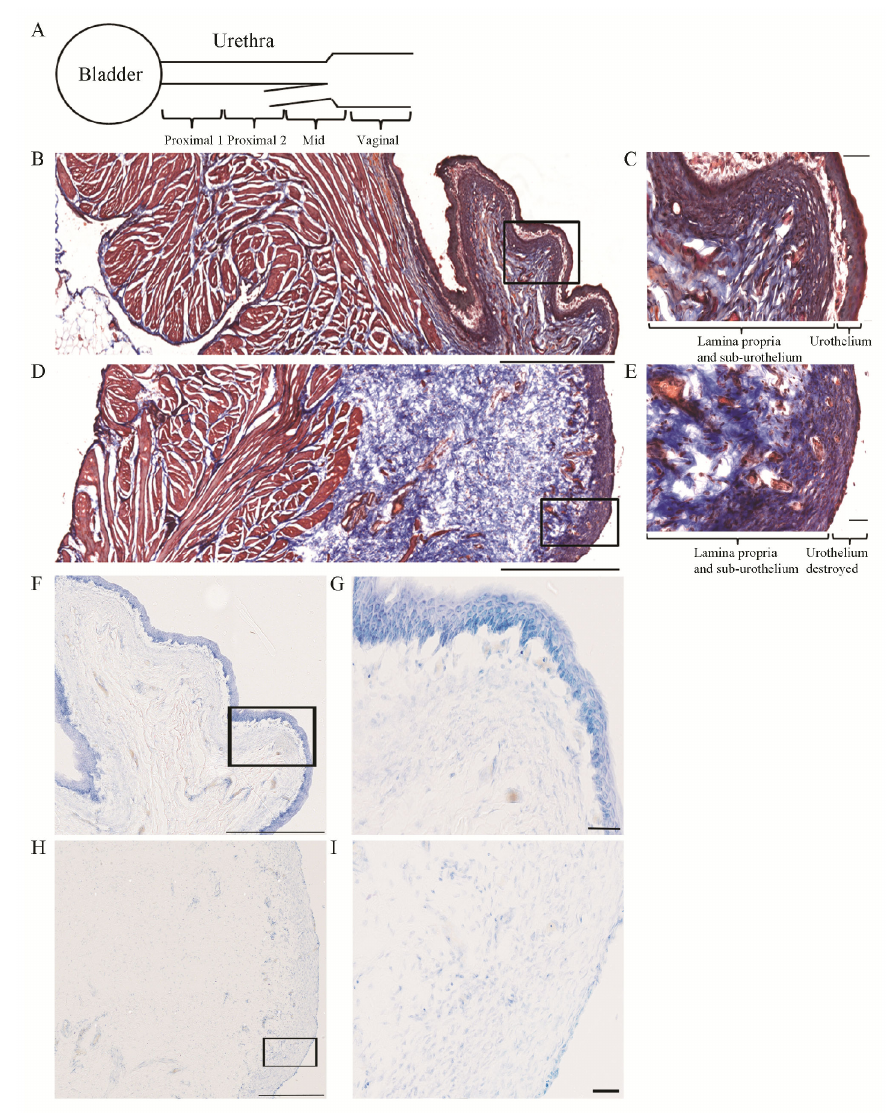
Figure 6. Histological evaluation of bladder tissue. A. Schematic of the preparation of bladder and urethra tissue for cryostat blocking and cutting. Bladder was cut in the longitudinal orientation. Urethra was cut in 4 blocks of 10 mm each, indicated by Proximal 1, Proximal 2, Mid and Vaginal, and transverse sections were cut from each block. B-E. Masson’s trichrome examples from a saline (B, C) and 0.5% acetic acid (D, E) infused bladder. Muscle tissue stains red/pink, collagen fibers stain blue, and nuclei stain